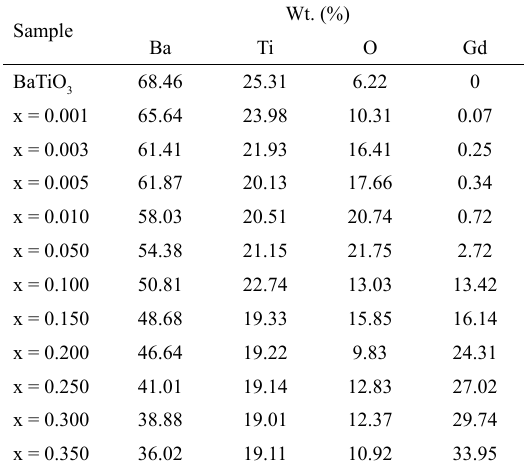
Figure 5: SEM-EDS micrographs of BaTiO All of the samples revealed comparable grain sizes.